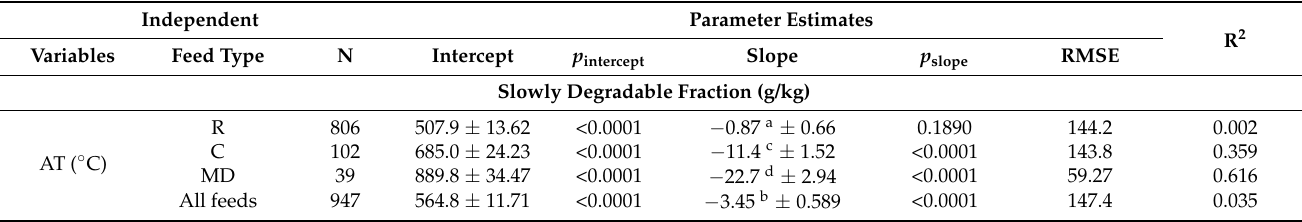
Table 5. Equations for linear regression between ambient temperature and dietary crude protein (independent variables) and slowly degradable fraction of fibre and potential degradability in the